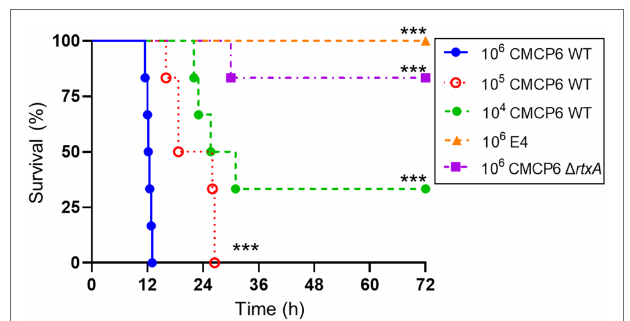
FIGURE 1 | Lethality of Vibrio vulnificus . Kaplan–Meier survival curves for mice subcutaneously inoculated with CMCP6 wild type (WT) 10 4 CFU/head ( n = 6), WT 10 5 CFU/head ( n = 6), WT 10 6 CFU/head ( n = 6), E4 10 6 CFU/head ( n = 6), and CMCP6 Δ rtxA 10 6 CFU/head ( n = 6) and monitored for 72 h. *** p = 0.0005 compared with CMCP6 WT 10 6 CFU/head; log-rank